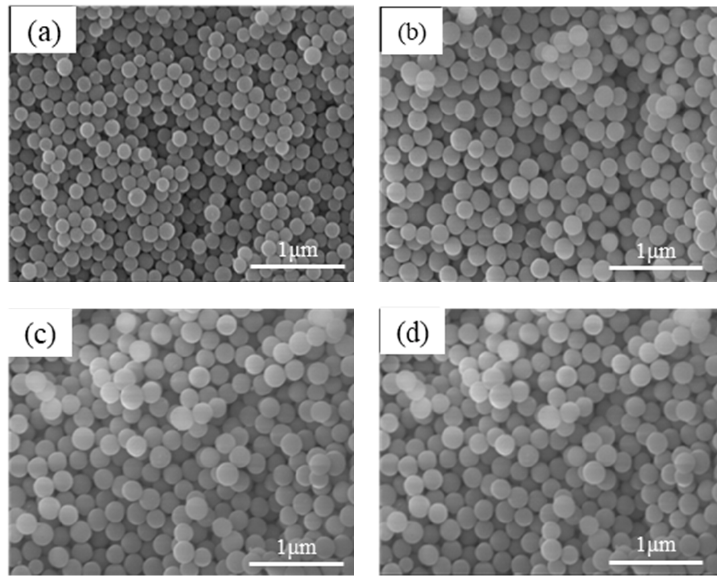
Figure 1. SEM images of SiO 2 nanoparticles prepared with TEOS weights of: ( a ) 1.5; ( b ) 4.0; ( c ) 6.0; and ( d ) 7.0 g.